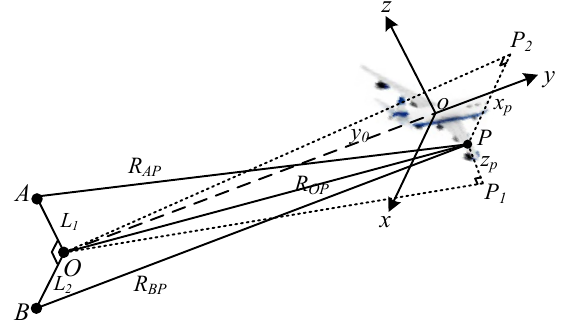
Figure 1. Schematic of the three-receiver interferometric inverse synthetic aperture radar (InISAR) imaging configuration.